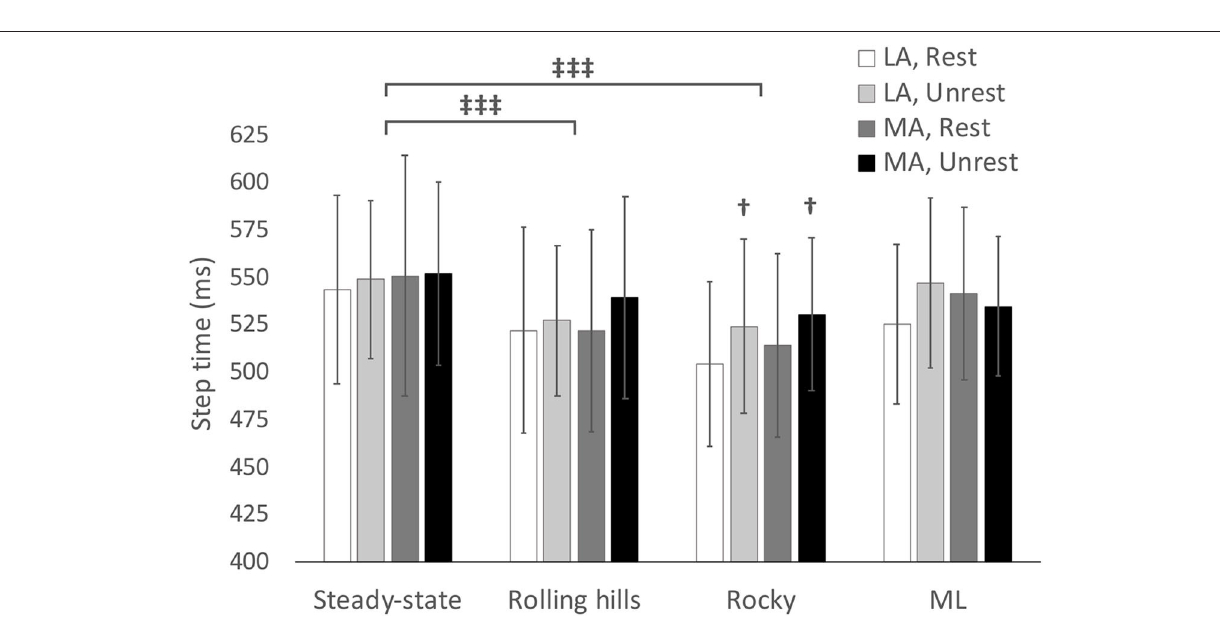
FIGURE 2 | Average step time with respect to terrain conditions for most (MA) and least affected (LA) leg in both restricted and unrestricted arm swing conditions. † represents significantly larger value in the unrestricted arm swing condition than restricted within the same leg and terrain condition p < 0.05. ‡‡‡ represents a significant difference between terrain conditions at p <